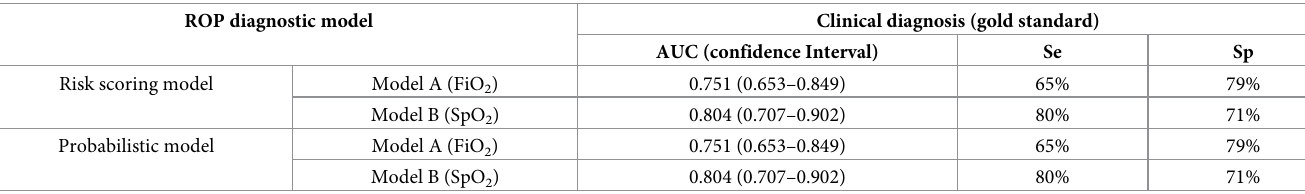
Table 2. Testing the validity of the risk scoring model and the probabilistic model for the risk of developing ROP with clinical diagnosis as the gold standard. ROP diagnostic